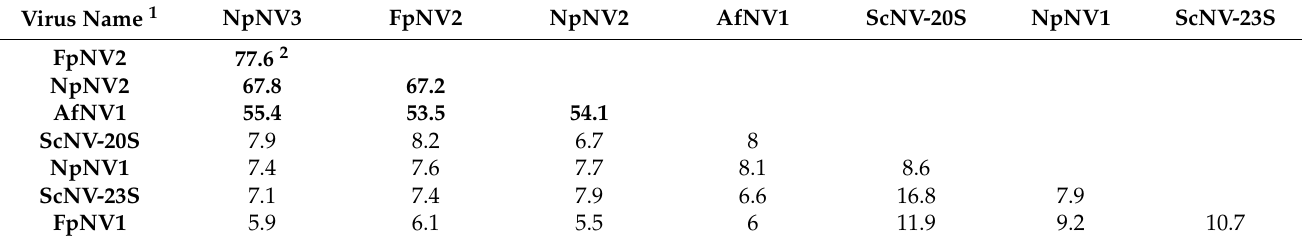
Table 3. Percentage of amino acid identity between representative members of the genus Narnavirus in the RdRp protein. Virus Name